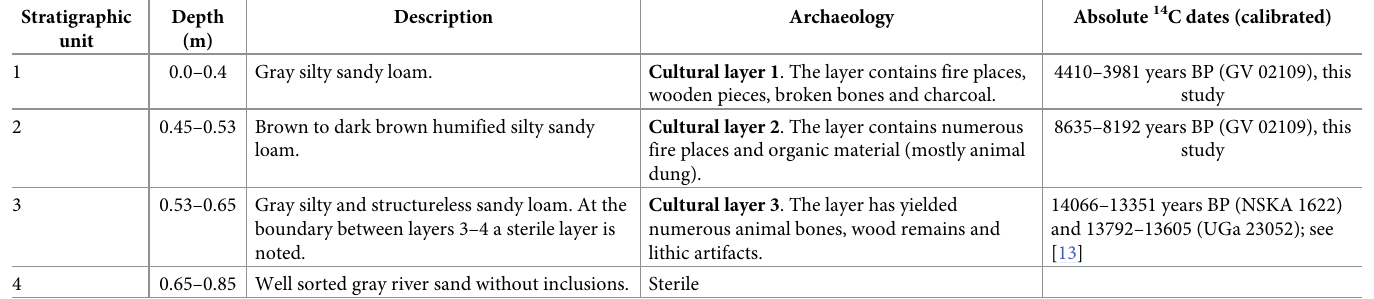
Table 1. Stratigraphy of the Istykskaya